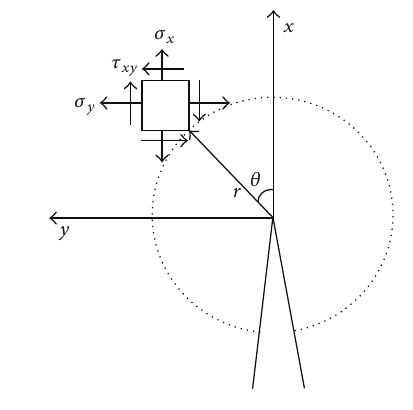
Figure 5: 2D plane strain of a crack.